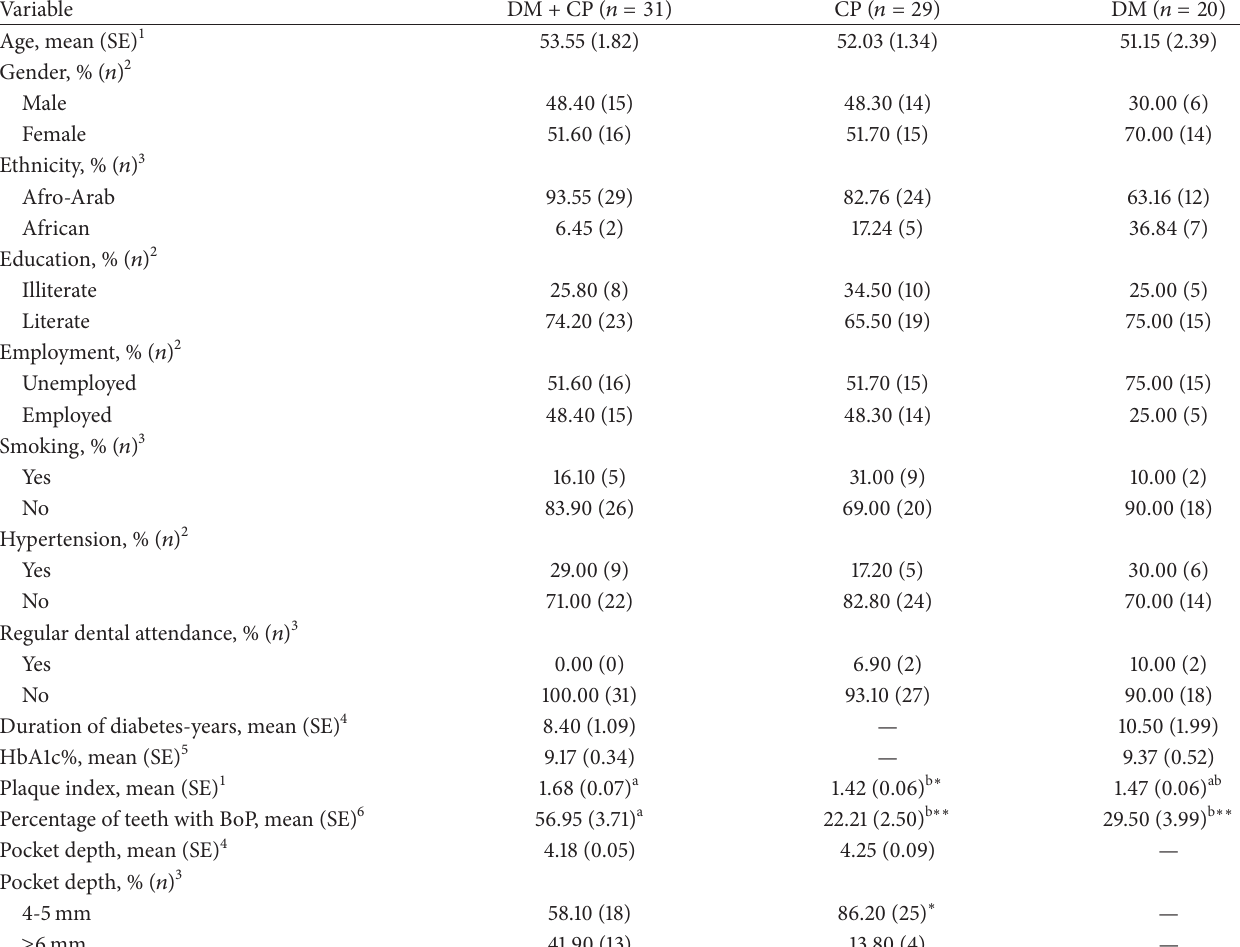
Table 1: Distribution of sociodemographic and clinical